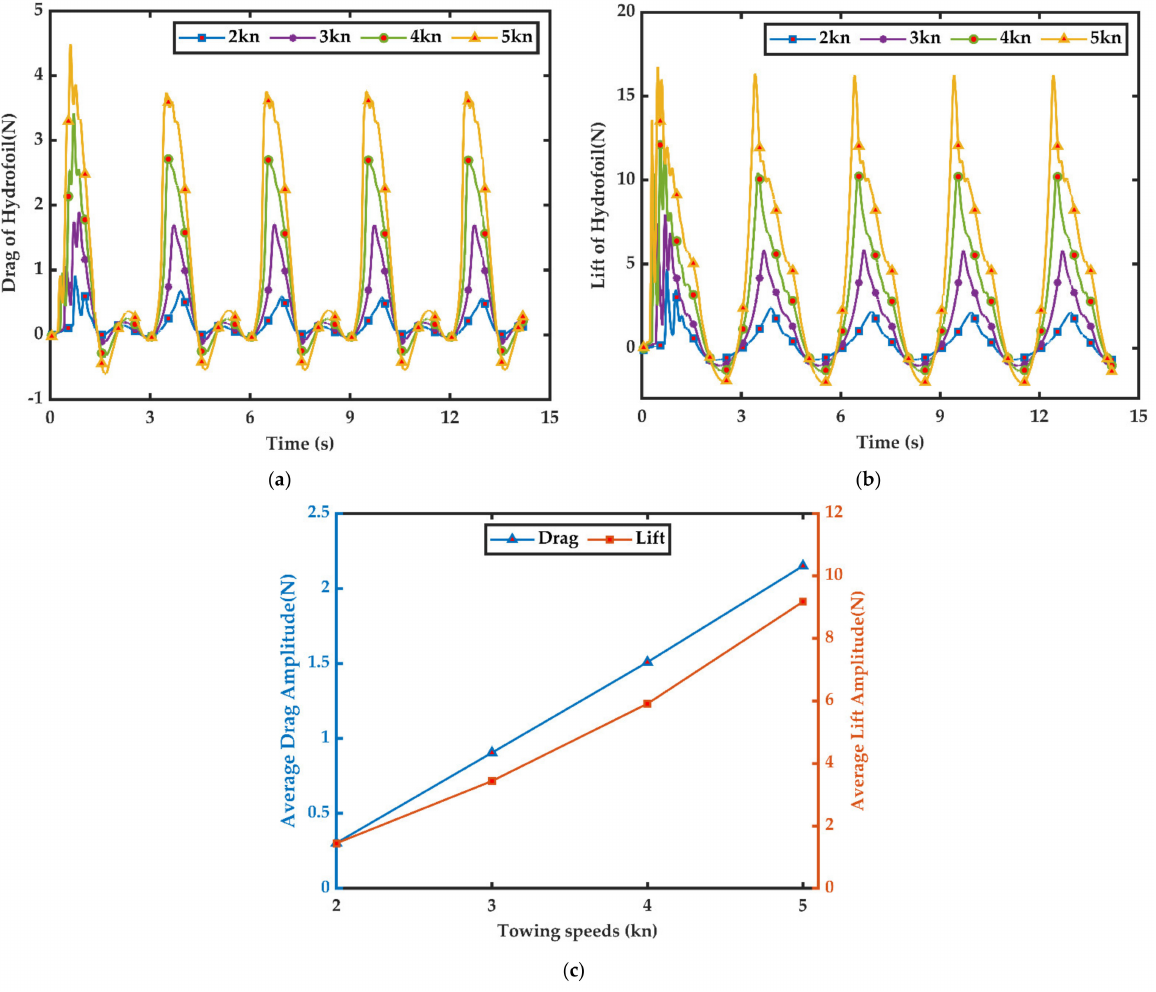
Figure 11. Time history of the drag and lift of the hydrofoil at different towing speeds: ( a ) drag of the hydrofoil; ( b ) lift of the hydrofoil; ( c ) average drag and lift